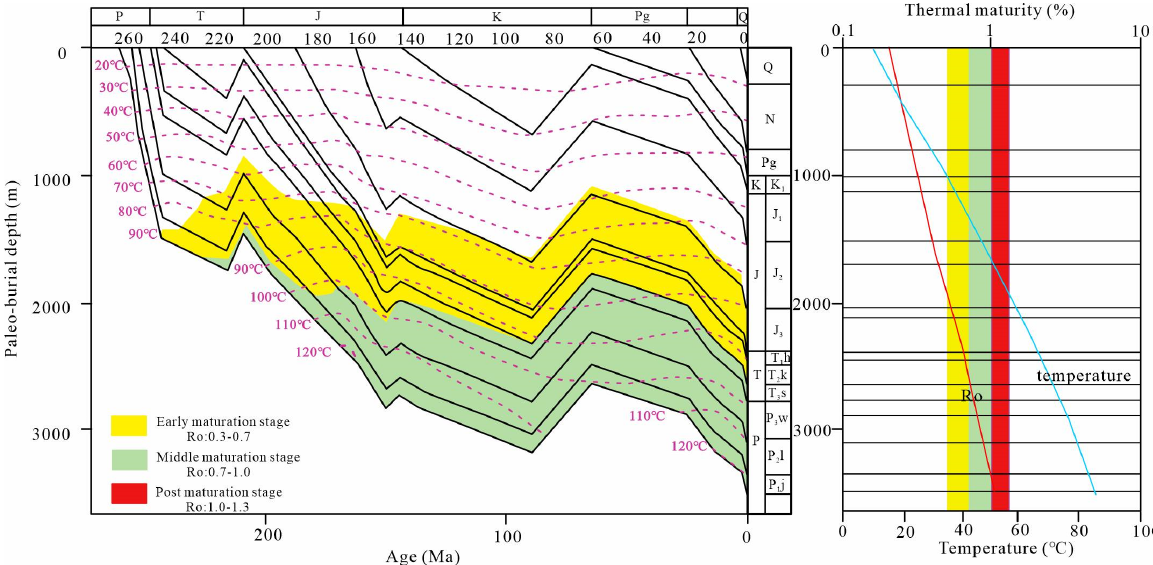
Figure 3. Burial history of Lucaogou Formation in Jimusaer Sag (modified from Fang et al. [28] and Qiu et al. [29]). Table 2. Thermal simulation control conditions for hydrocarbon expulsion.